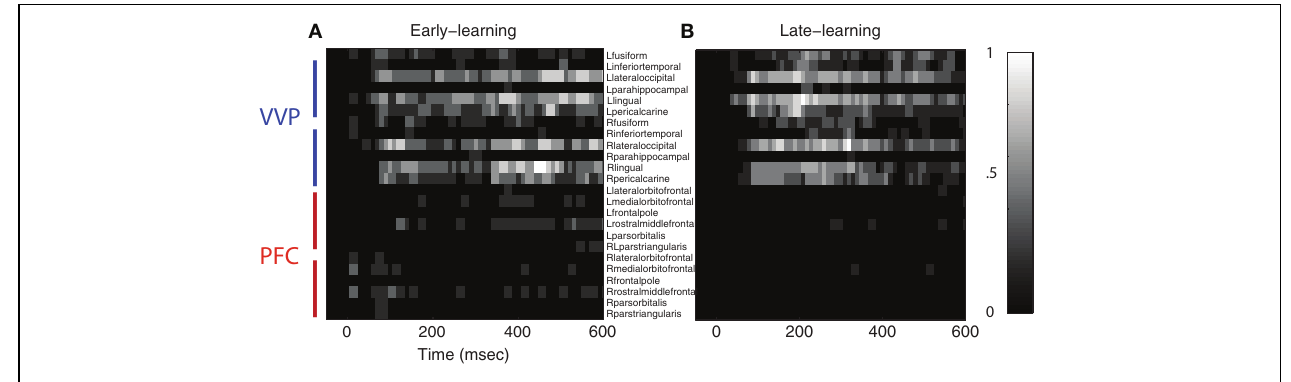
FIGURE 5 | Regions of interest in ventral visual and prefrontal cortices after excursion tests. (A) Group-aggregated regions of interest during early learning. (B) Group-aggregated regions of interest during